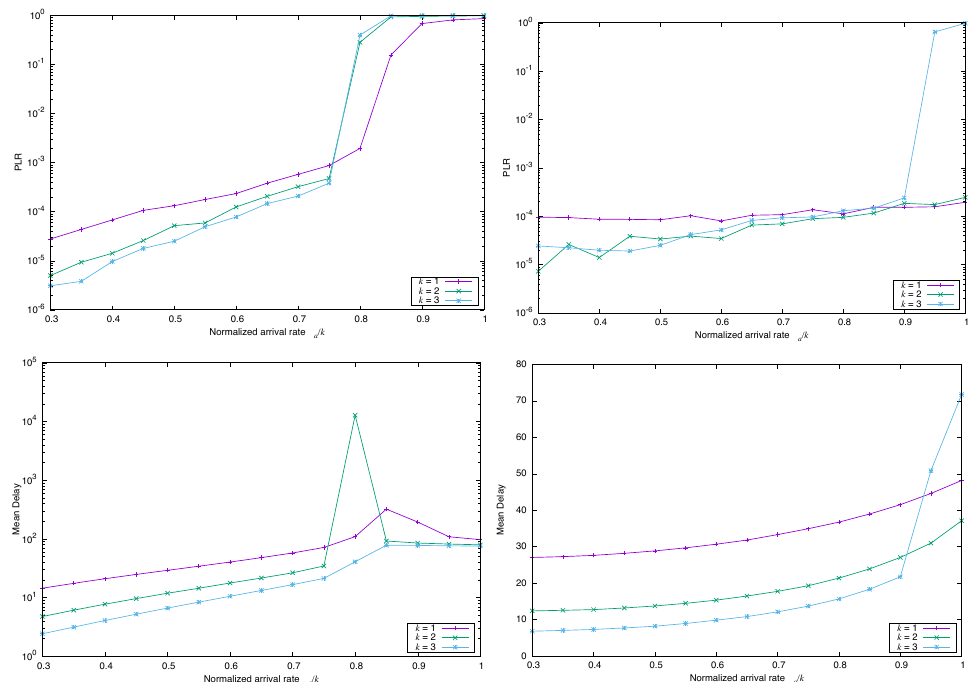
Figure 8. Simulated PLR ( top ) and Mean Delay ( bottom ) for FA-CSA versus λ a / k , with Λ ( x ) = 0.86 x 3 + 0.14 x 8 , n = 200 and k = { 1,2,3 } , and marginal distribution Poissonian ( left ) and Lognormal ( right ), in both cases µ = σ 2 .